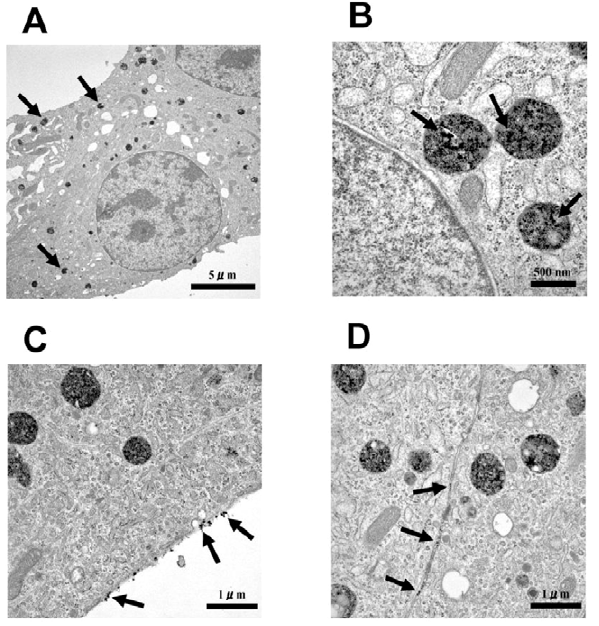
Figure 2. Electron microscopy of MIN6 cells labeled with TMADM-03. A. The morphology of the MIN6 cells labeled with TMADM-03. The arrows point to lysosomes containing the nanoparti- cles; 6 4,860. B. Nanoparticles (arrows) detected in the lysosomes; 6 30,200. C. Nanoparticles (arrows) attached to the cell membrane; 6 18,400. D. Nanoparticles (arrows) trapped between cells; 6 18,400.